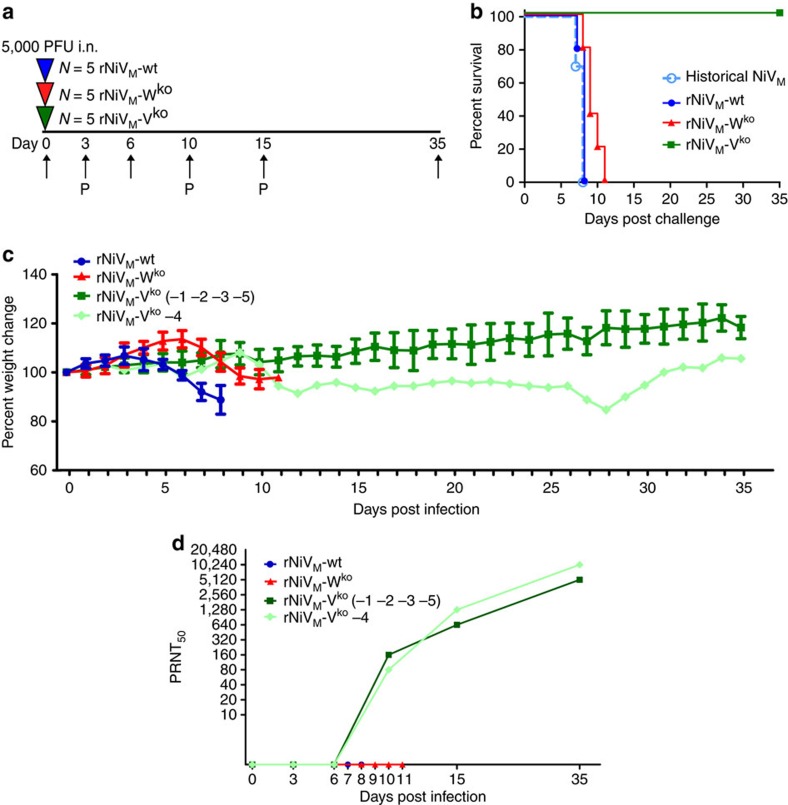
Clinical disease in ferrets after experimental infection with rNiVM.(a) Flow chart showing the day of infection (triangles) and days of sample collection (arrows). P, Pilot animals (numbers -1 and -2 from each cohort) were not sampled on these days. (b) Kaplan–Meier survival curve for ferrets infected with rNiVM-wt (blue circles), rNiVM-Wko (red triangles) and rNiVM-Vko (green squares); historical natural, non-recombinant NiVM controls have been included (light blue dotted line, open circles; N=10). Log-rank (Mantel–Cox) test; N=5 for all rNiVM ferret cohorts. *P value<0.05; **P value<0.01 compared with rNiVM-wt. (c) Weight change for animals from the rNiVM-wt cohort (blue circles), rNiVM-Wko cohort (red triangles), rNiVM-Vko cohort animals −1, −2, −3 and −5 (dark green squares) and animal rNiVM-Vko-4 (light green diamonds). Ferret rNiVM-Vko-4 is separated from the rest of the rNiVM-Vko cohort because it showed distinct clinical signs. (d) Neutralizing antibody titres for each ferret cohort. Error bars show s.d.